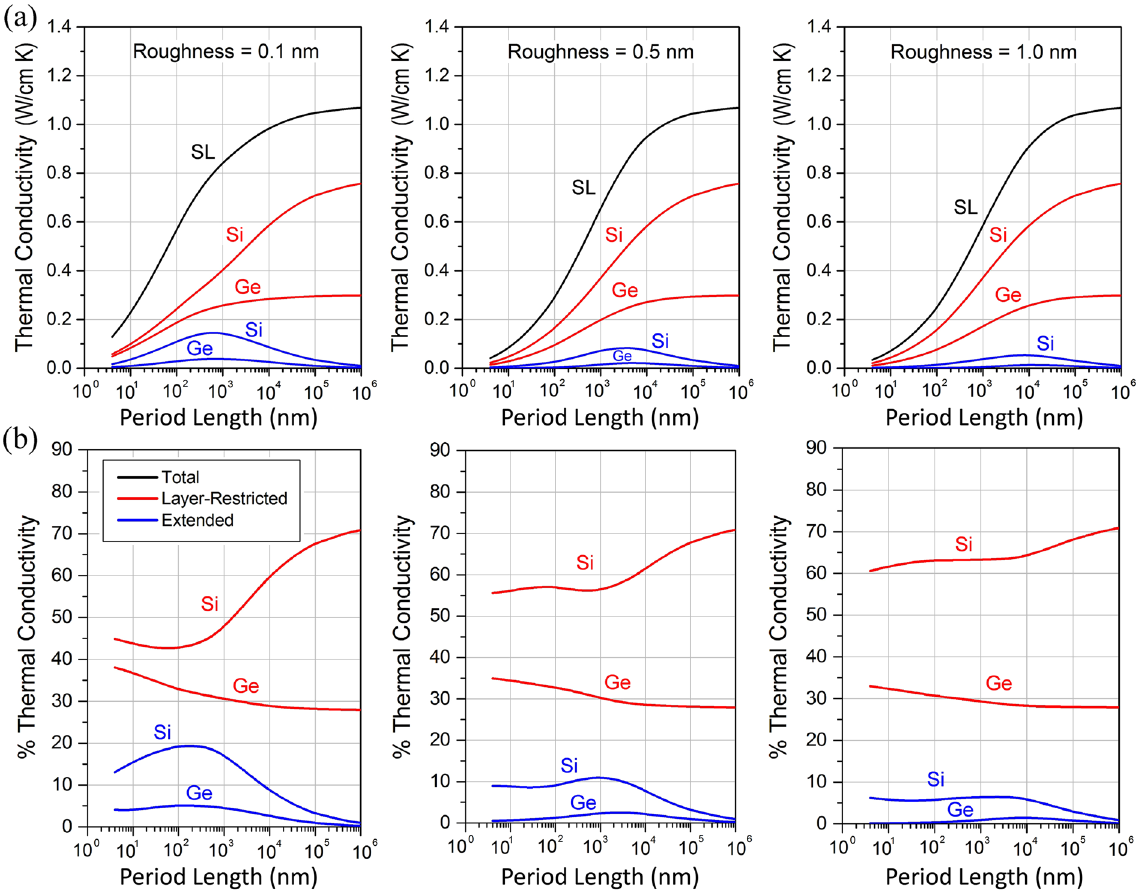
Figure 2. ( a ) Distribution of thermal energy carried by for layer-restricted phonons (red), extended phonons (blue), and total thermal conductivity (black) as a function of superlattice period length for surface roughness η = 0.1 nm, 0.5 nm, and 1.0 nm. ( b ) Variation of percentage contribution of extended and layer-restricted phonons in Si and Ge to the total superlattice thermal